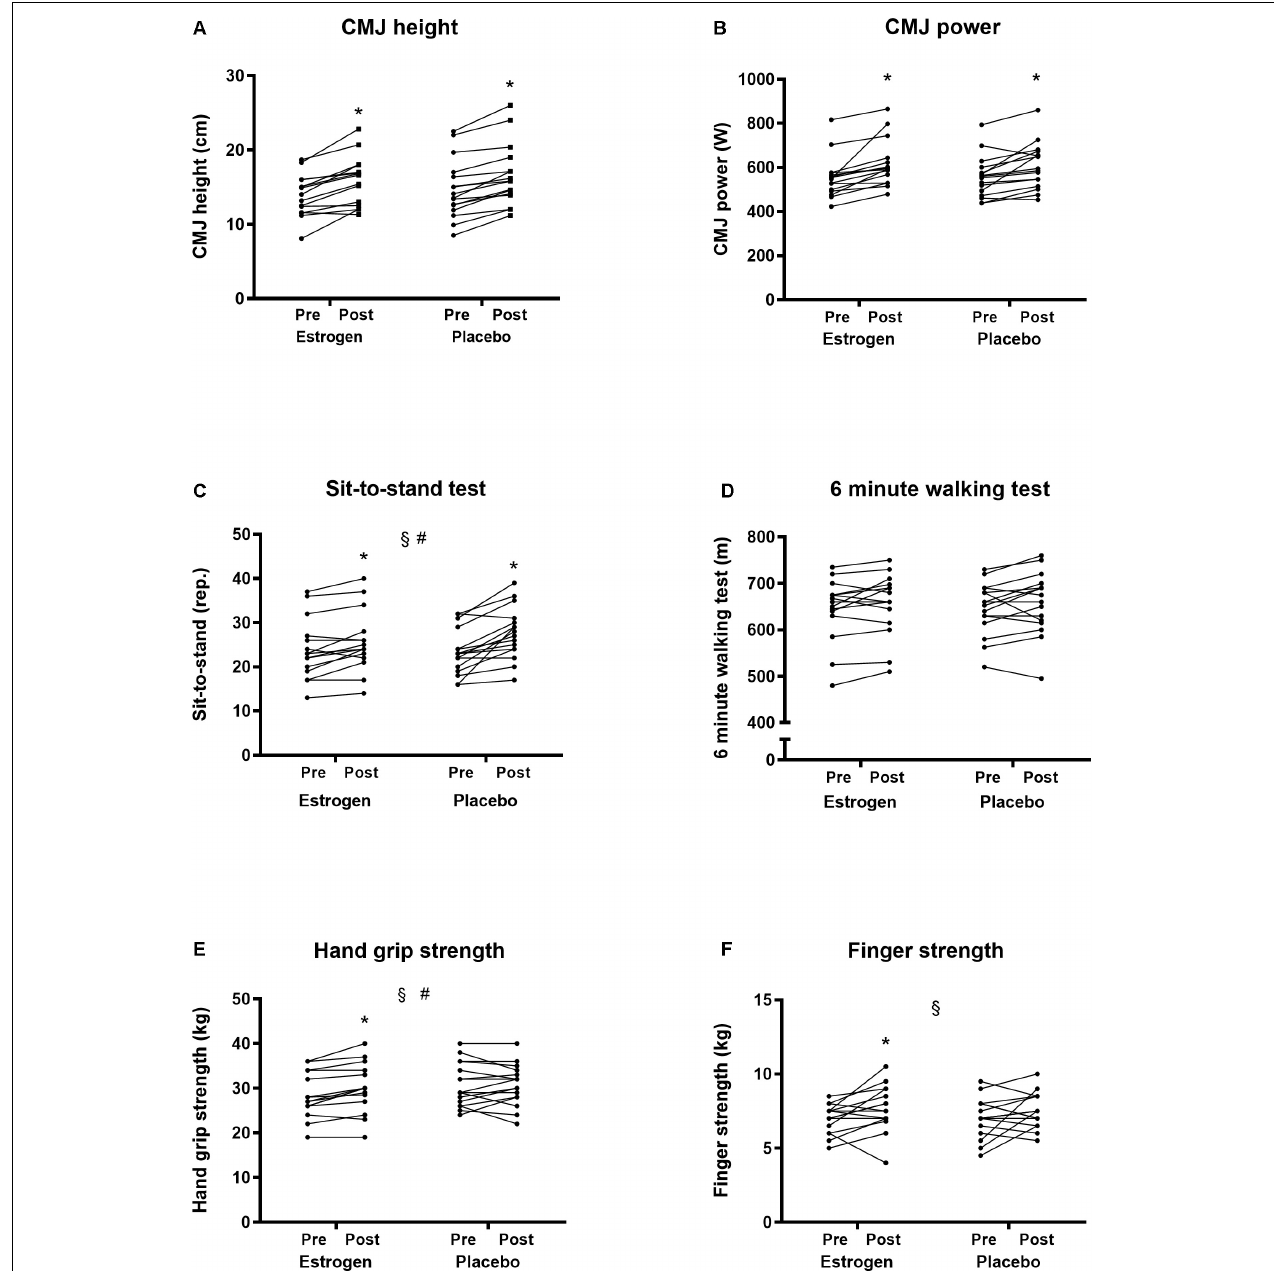
FIGURE 4 | (A) Countermovement jump height. (B) Power in countermovement jump. (C) Sit-to-stand-test. (D) Six minutes walking test. (E) Handgrip strength. (F) Finger strength before and after 12 weeks of resistance training in the individual participants in the ET and PLC group, respectively. # Group × time interaction ( p < 0.05). § Training effect ( p < 0.05). *Different from pre in the individual group ( p <